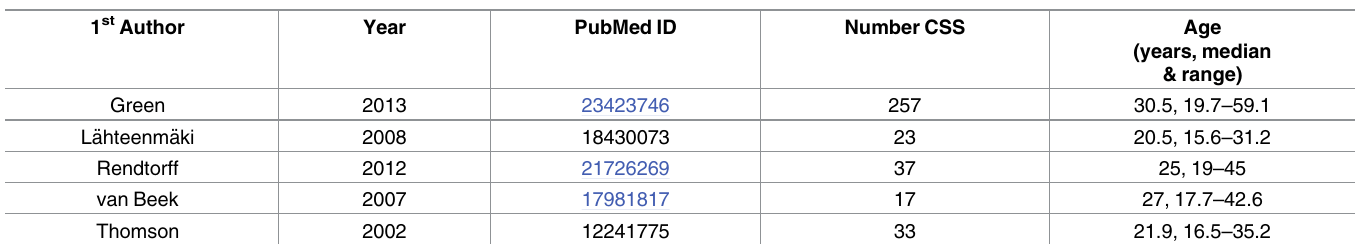
Table 1. Characteristics of the included studies.